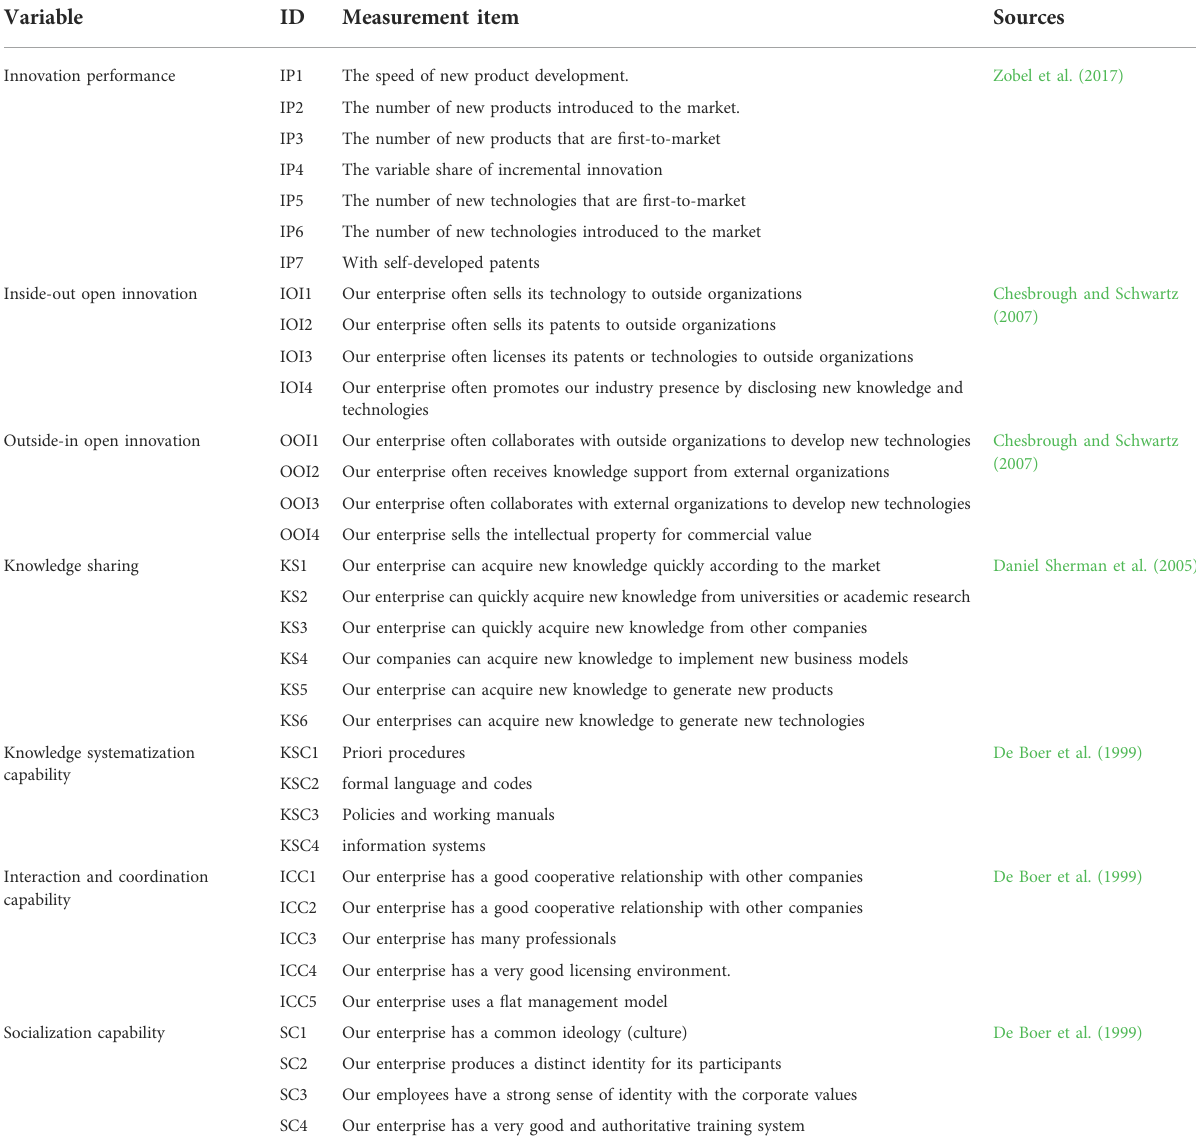
TABLE 2 Questionnaire. Variable ID Measurement